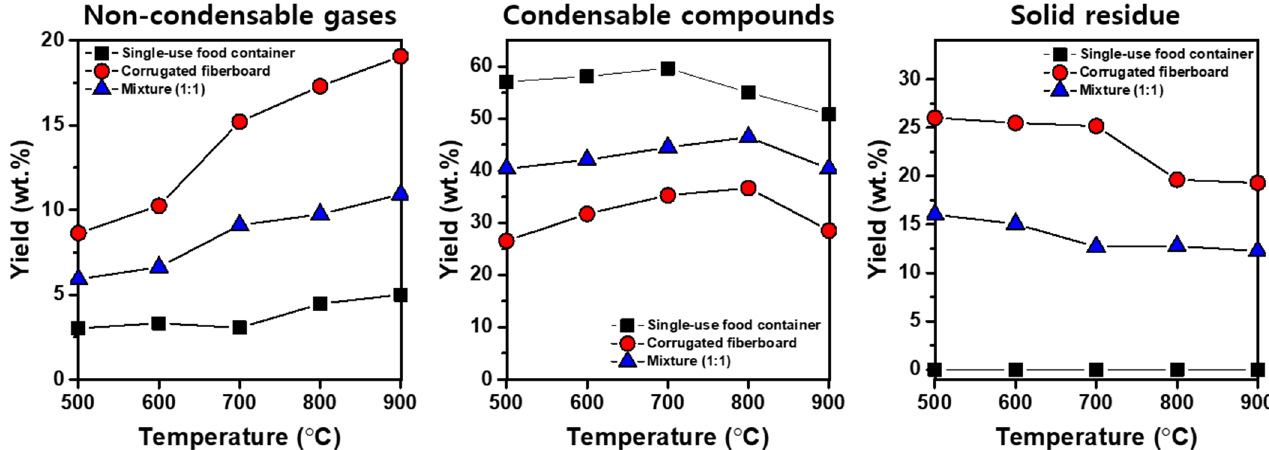
Figure 2. Yields of the pyrolytic products produced via the pyrolysis of single-use food containers, corrugated fiberboard, and a mixture of single-use food containers and corrugated fiberboard (1:1; mass basis) as a function of pyrolysis temper- ature.